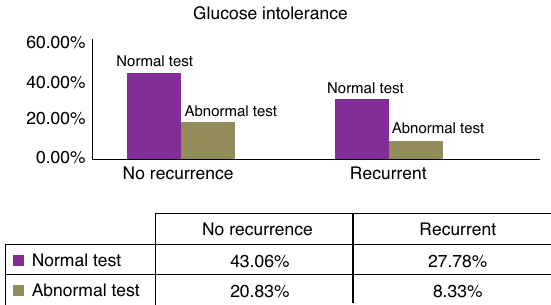
Figure 2 Distribution of patients with BPPV recurrence, regarding tests with glucose